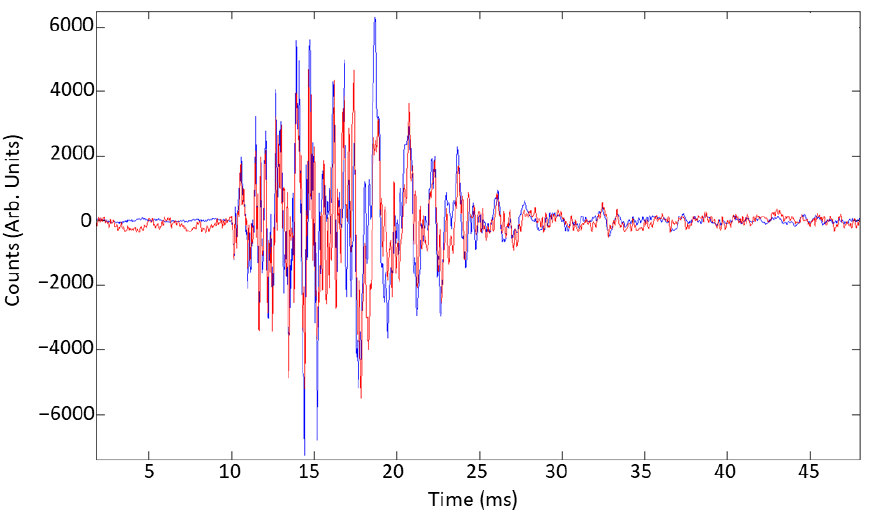
Figure 7. Raw seismic data from Whillans Ice Stream comparing geoPebble (red) with COTS Nano- metrics Geode